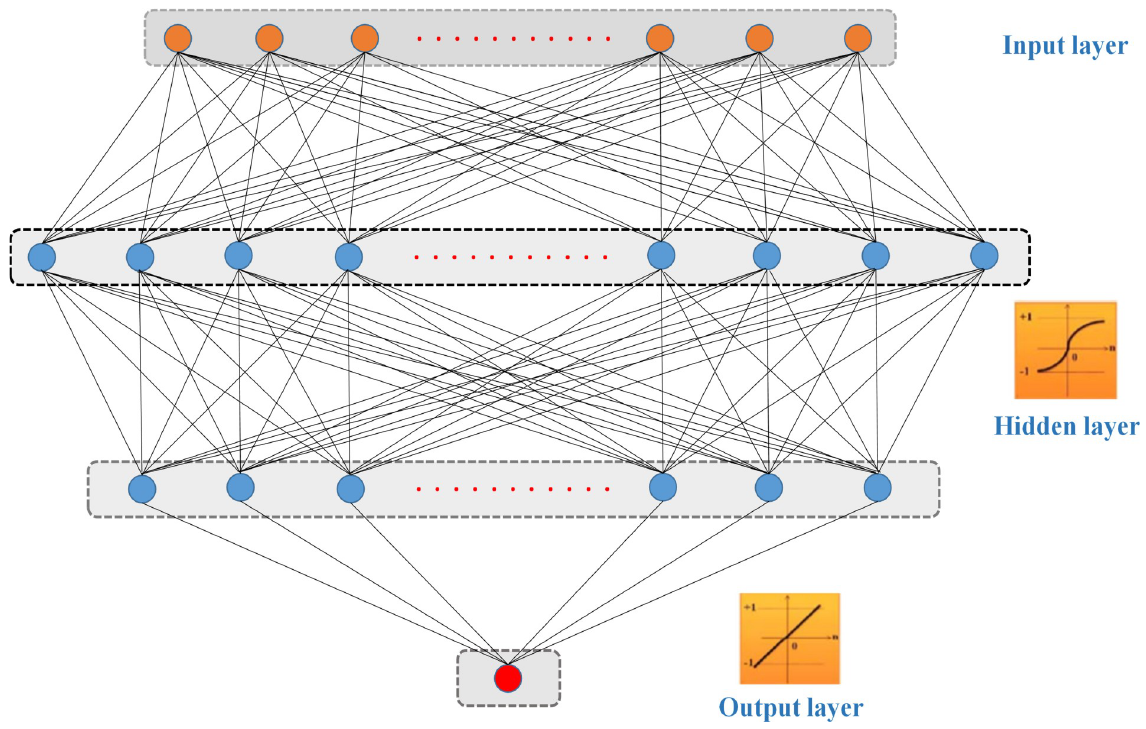
Fig 3. An ANN framework used in this